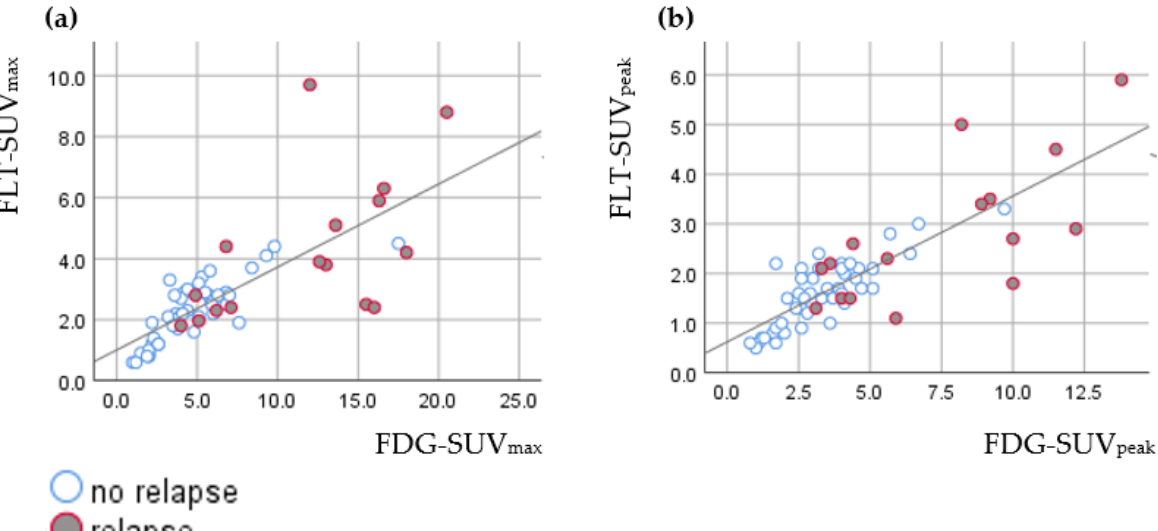
Figure 3. Correlation of ( a ) FDG-SUV max and FLT-SUV max with linear fit (R = 0.804; p < 0.001; spearman’s correlation), and ( b ) FDG-SUV peak and FLT-SUV peak with linear fit (R = 0.770; p < 0.001; spearman’s correlation).